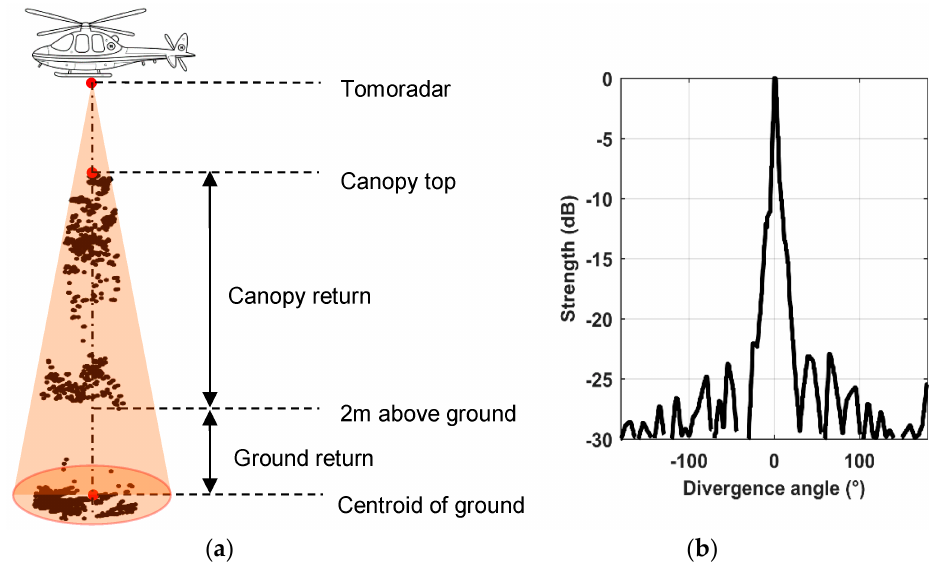
Figure 5. ( a ) The Velodyne ® LiDAR point cloud within one Tomoradar footprint cone, the ground return and canopy return are derived by calculating the number of point cloud in the specified region; and ( b ) the Tomoradar transmitted antenna pattern, and its divergence angle is inconstant with the variability of strength.